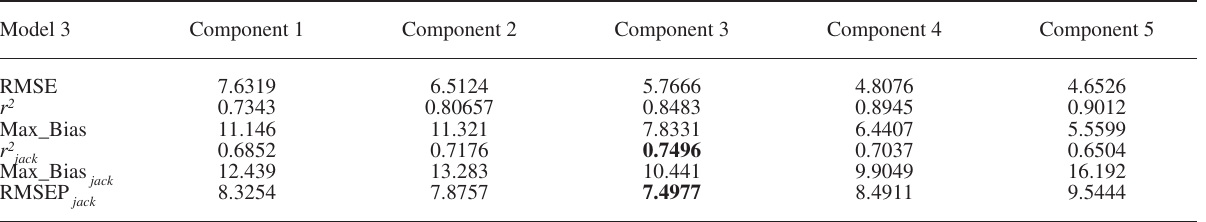
Table 2. – Statistics summary of the performance of Wa-PLS (weighted averaging partial least squares) for the foraminiferal assemblages from the Basque marshes corresponding to model 3 (from Leorri et al ., 2008a). model 3